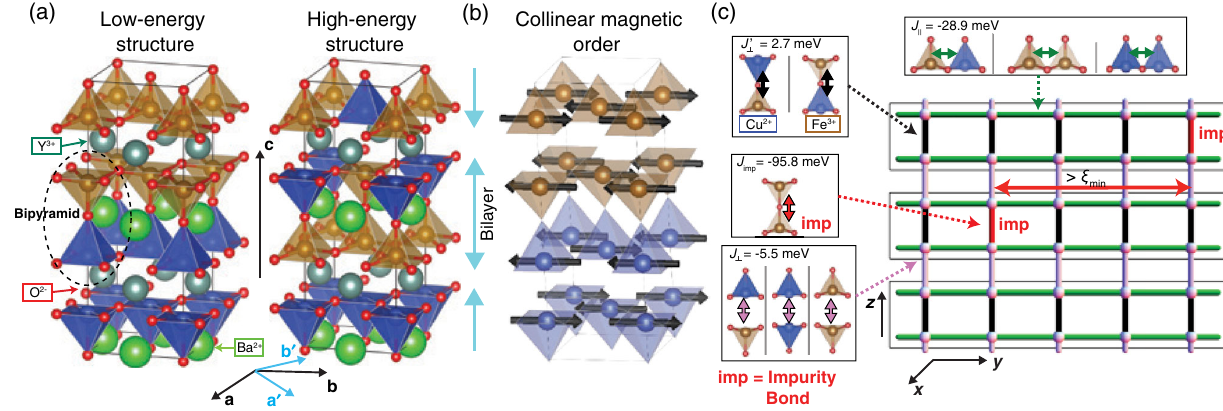
ffiffiffi ffiffiffi p p 2 2 FIG. 1. (a) Two different orderings of Cu 2 þ and Fe 3 þ in the × × 2 supercell of YBaCuFeO 5 . The FeO 5 and the CuO 5 square pyramids are shown in gold and blue, respectively. The left panel shows a low-energy structure consisting only of Fe 3 þ -Cu 2 þ bipyramids. The right panel shows a high-energy structure with one Fe 3 þ -Fe 3 þ and, upon periodic repetition, one Cu 2 þ -Cu 2 þ bipyramid. (b) Unfrustrated magnetic order in the commensurate phase. (c) Simplified spin model for YBaCuFeO 5 with nearest- neighbor exchange interactions. The a 0 and b 0 axes are rotated by 45° with respect to the a and b axes in diagram (a). The magnetic ions corresponding to either Cu 2 þ or Fe 3 þ are depicted as pink spheres. They form bilayers (regions enclosed by the rectangles) obtained by stacking a pair of x - y square lattices (corresponding to YBaCuFeO 5 bilayers) along the z axis. The antiferromagnetic exchange coupling 3 þ with Fe 3 þ , Cu 2 þ with Cu 2 þ , or Fe 3 þ with Cu 2 þ . The interlayer J ∥ within a layer is assumed to be independent of whether it couples Fe coupling J 0 ⊥ within a bilayer is ferromagnetic for Cu 2 þ -Fe 3 þ bipyramids (see text). Impurity bonds have a strong antiferromagnetic exchange, J , similar in magnitude to the ab initio value for Fe 3 þ -Fe 3 þ bipyramids. The impurity bonds are randomly distributed, up to imp the constraint that two impurity bonds in adjacent bilayers cannot be closer than a minimal distance ξ min